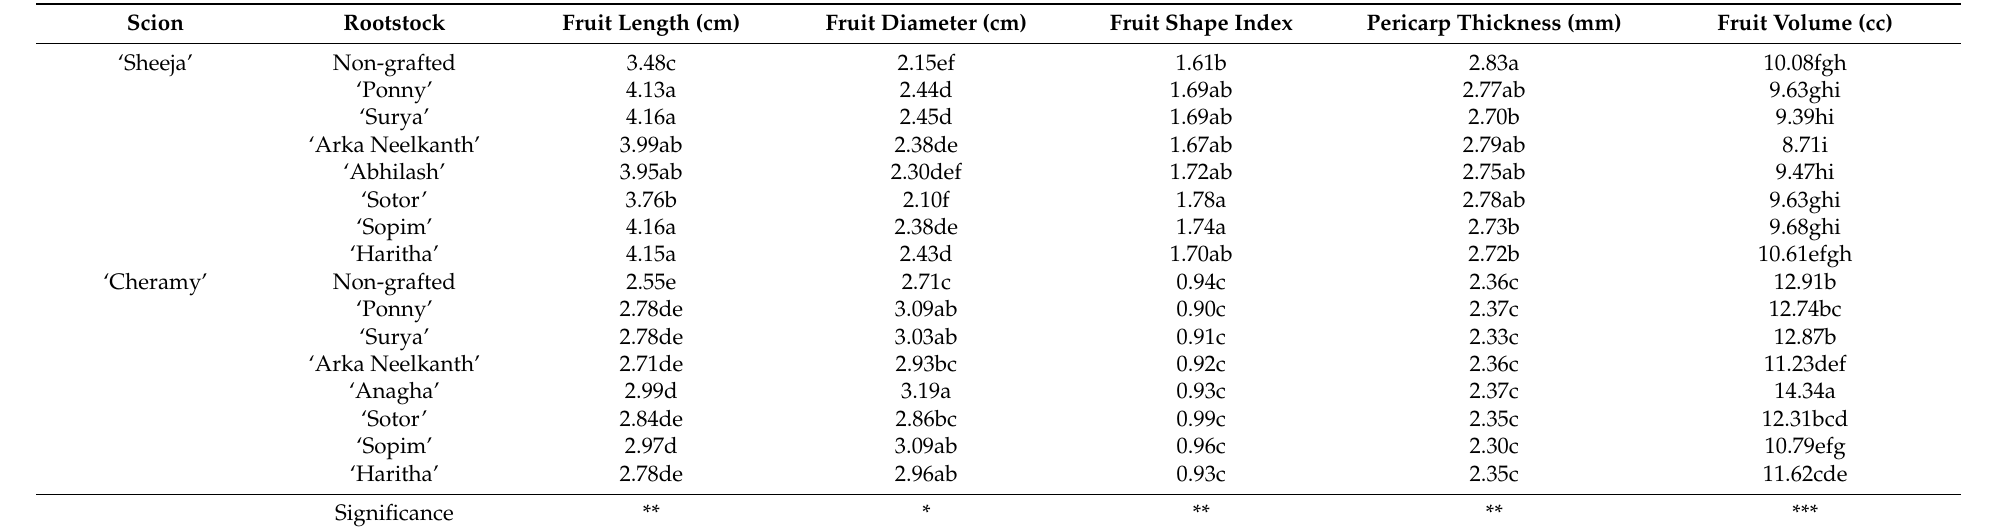
Table 7. Fruit length, diameter, shape index, pericarp thickness and volume of cherry